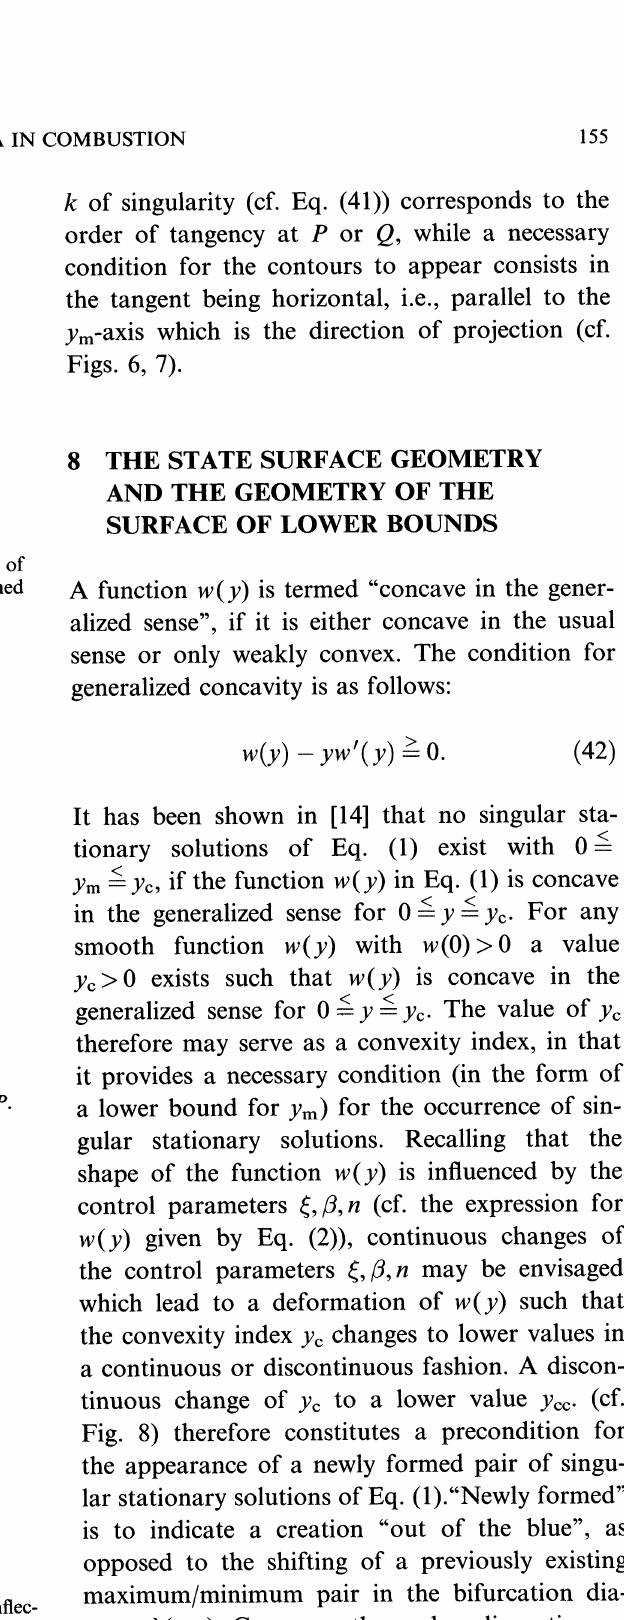
A bifurcation diagram with point of FIGURE 7 tion Q.